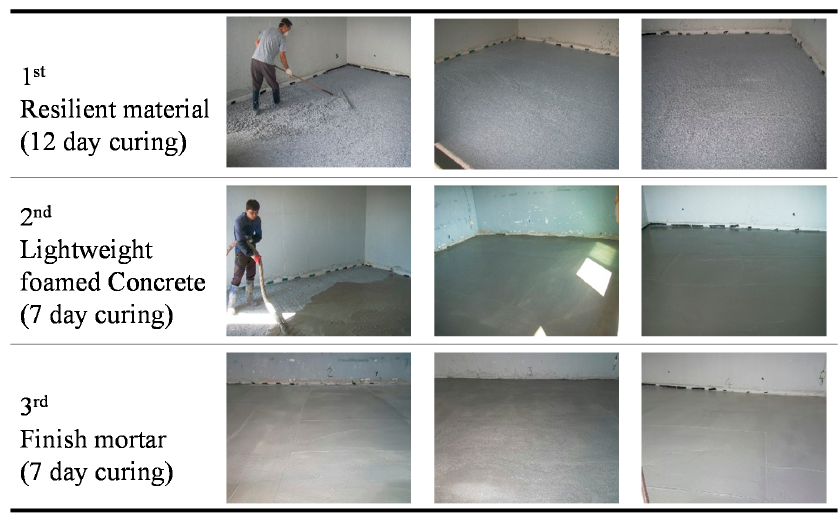
Figure 12. Construction process for floor system using resilient materials.